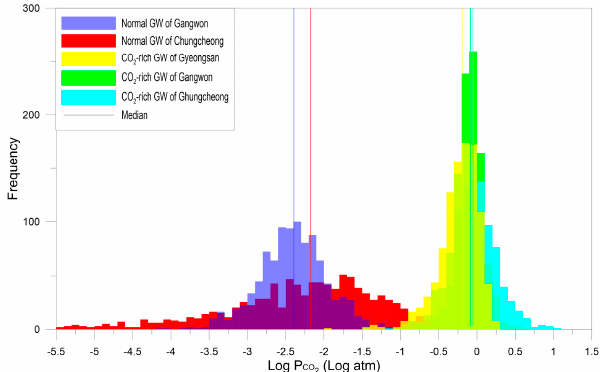
Figure 7. logP (cid:2887)(cid:2899) threshold for separating CO 2 -rich (blue, green, and yellow distributions) and ordinary (red and dark blue distributions) groundwaters in South Korea. Yellow box line indicates − 0.97 and separates logP (cid:2887)(cid:2899) of CO 2 -rich groundwater from that of ordinary groundwater with the same confidence interval of 97.4%.